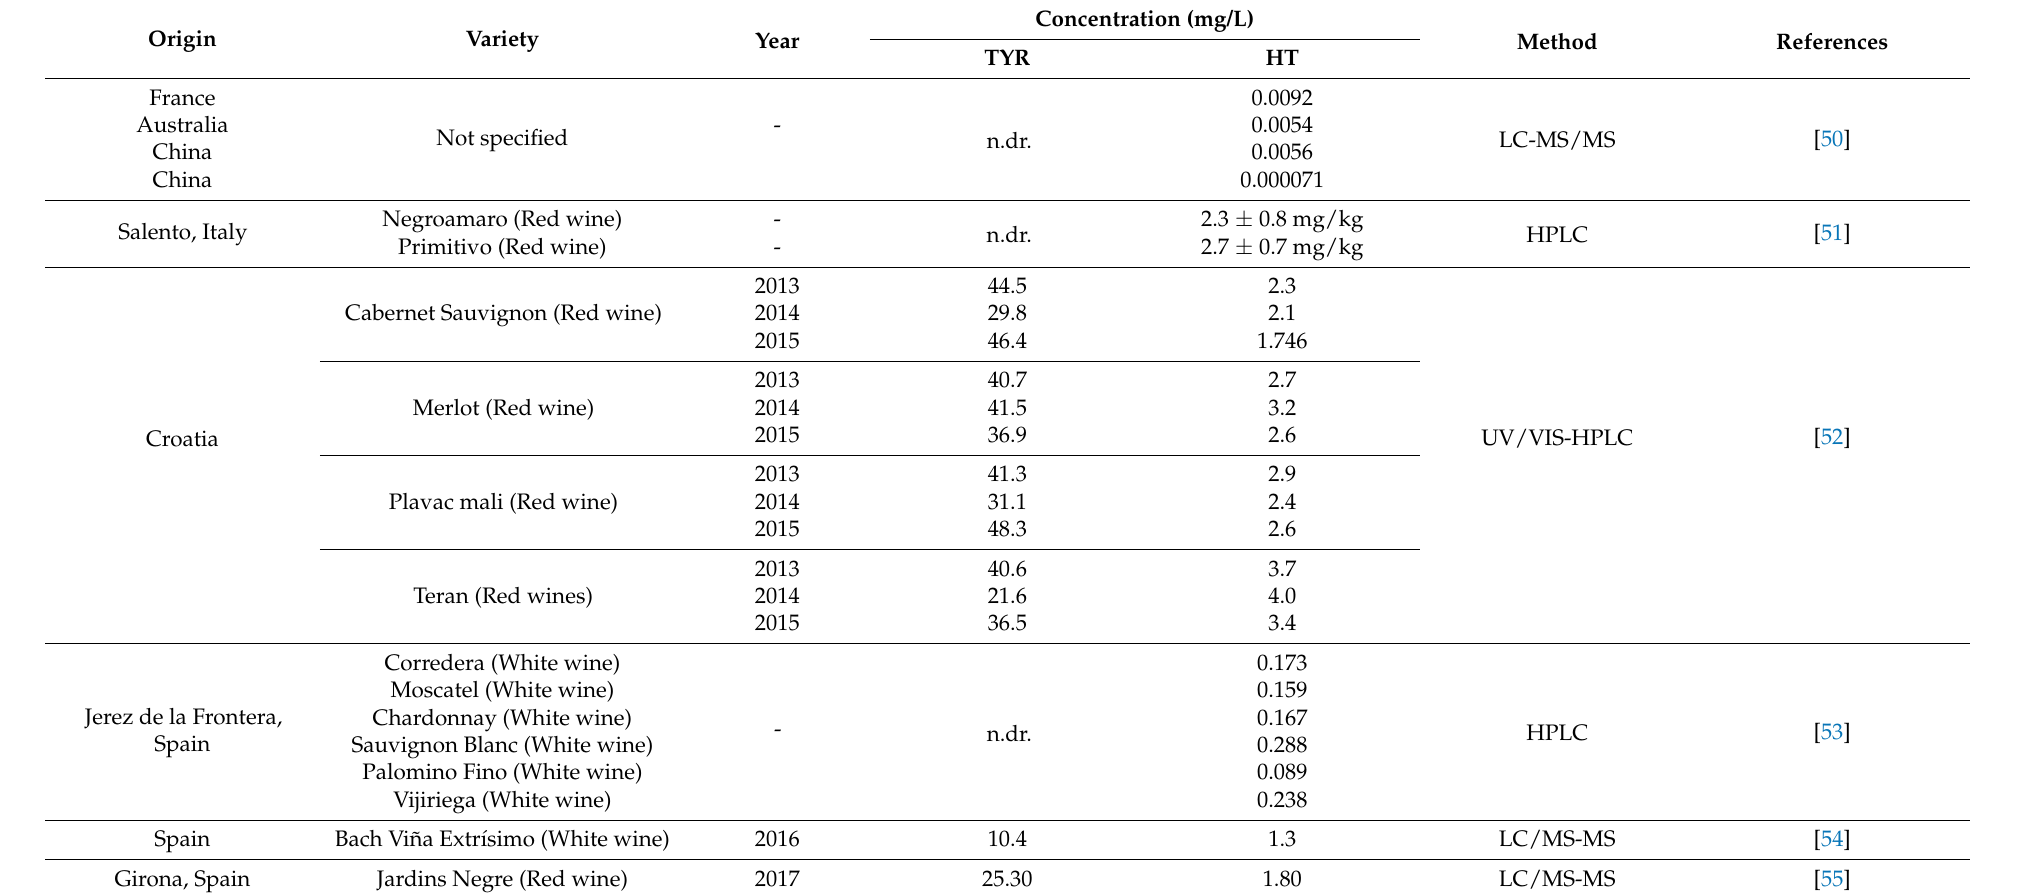
Table 3. Tyrosol (TYR) and hydroxytyrosol (HT) content in wine according to origin, variety, and method of